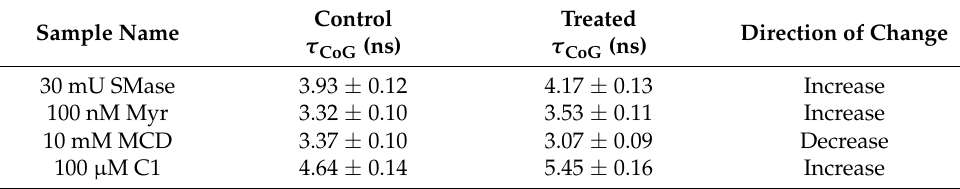
Table 1. τ CoG values determining the rate of change of CoG in control and treated samples. Errors are the intrinsic measurement errors.